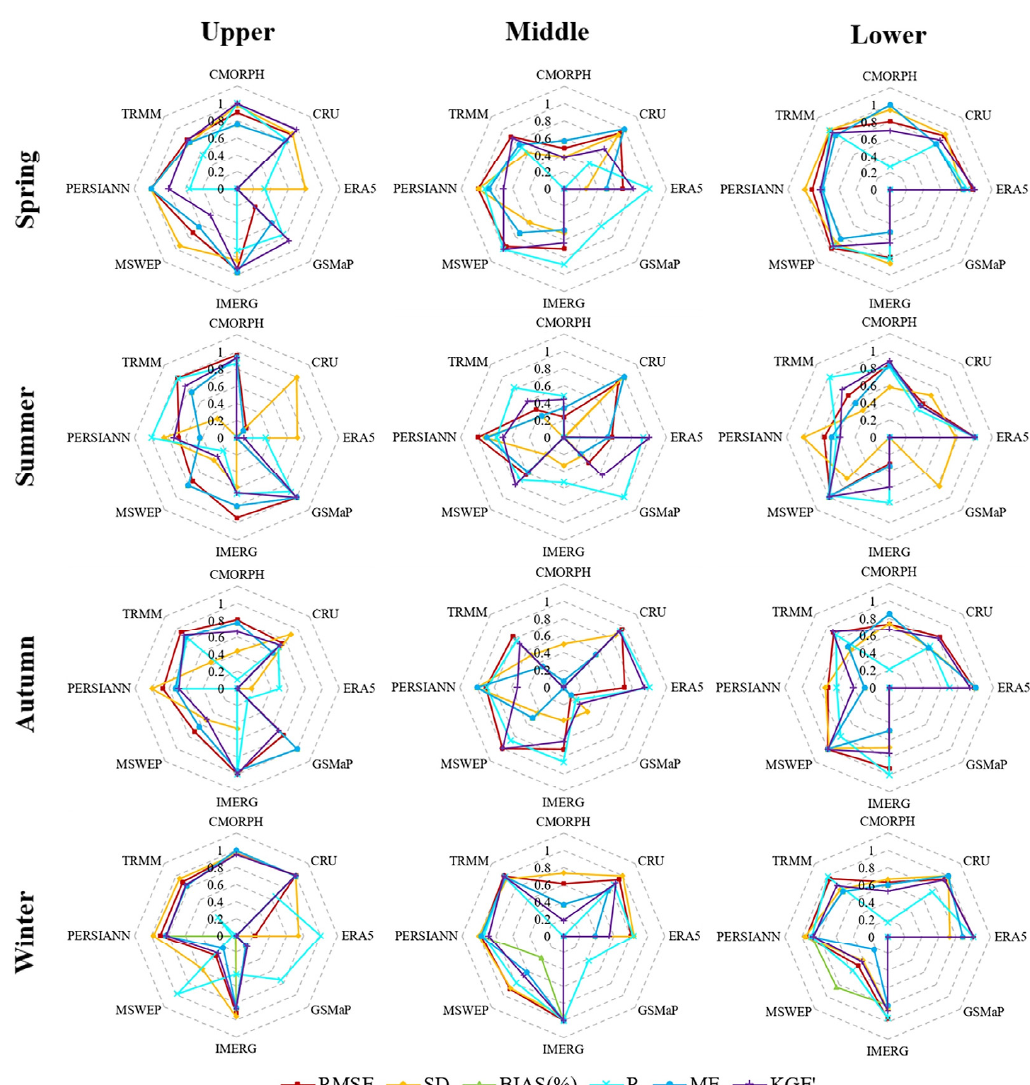
Figure 8. Radar plots of six indices of seasonal precipitation estimates from each product between observations at stations for different seasons and regions during 2016–2019.